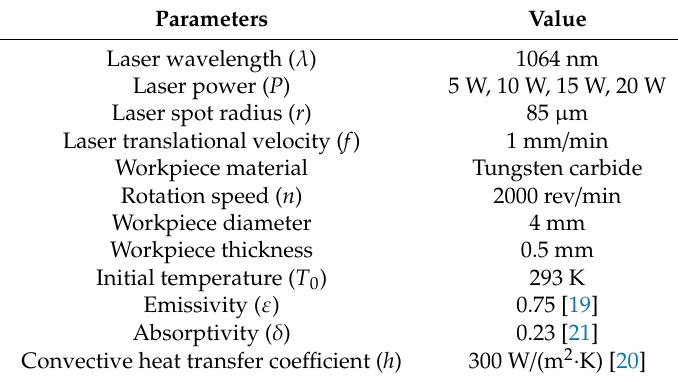
Figure 1. Finite element analysis (FEA) model of laser heating. Table 1. Finite element analysis (FEA) simulation parameters